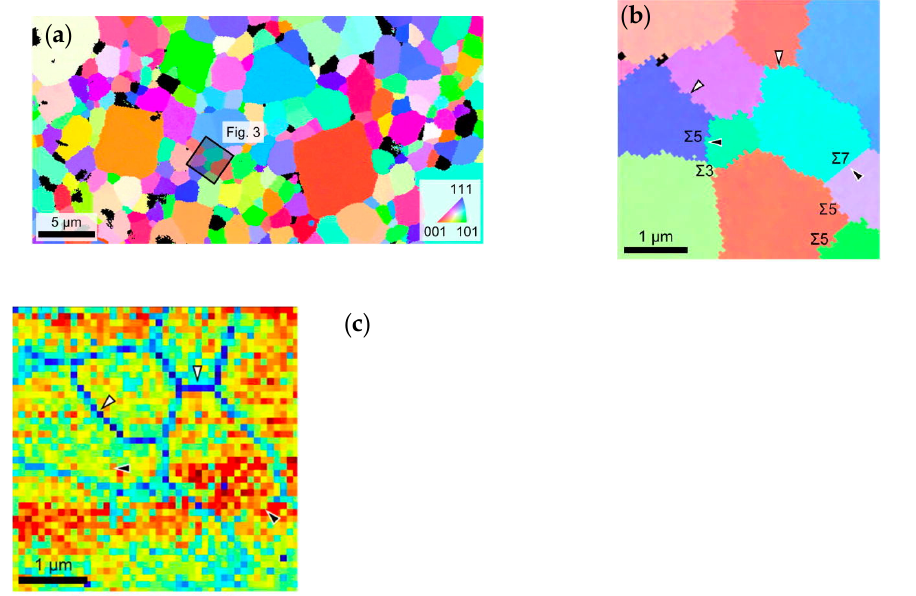
Figure 6. ( a ) SEM-EBSD crystallographic orientation map for LLTO; ( b ) the enlarged area from the black-square; and ( c ) ESM loop area map at the voltage of 20 V. Reprinted from [74], with the permission of AIP Publishing.